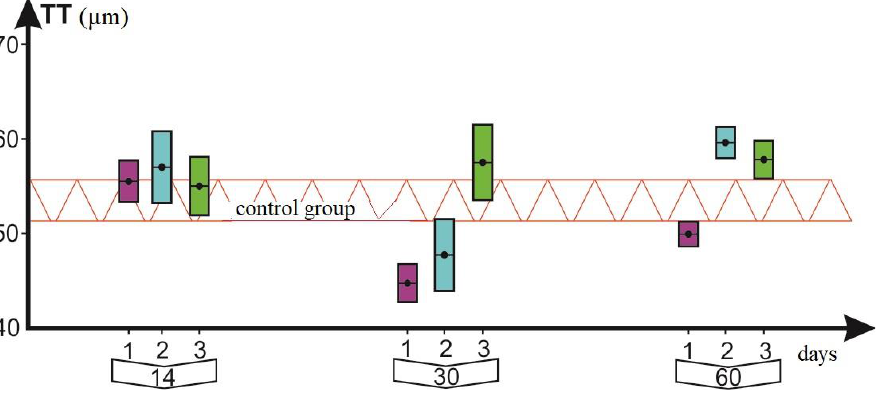
Figure 7. Trabeculae thickness dynamics. The colors and designations are the same as for Figure 4.